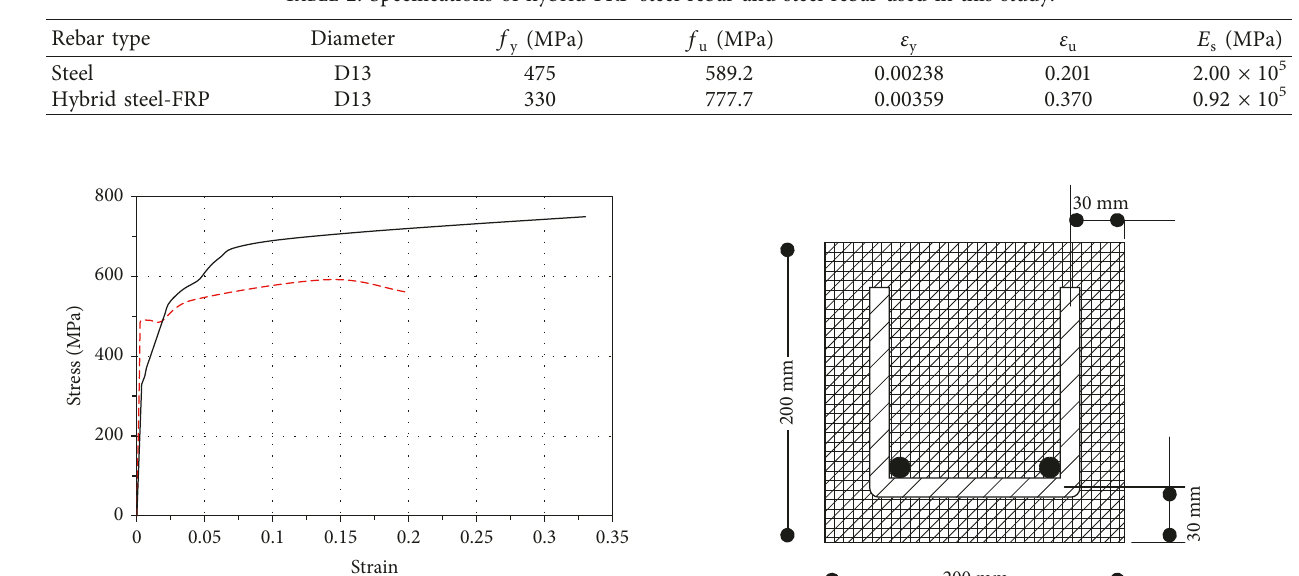
Table 2: Specifications of hybrid FRP-steel rebar and steel rebar used in this study.